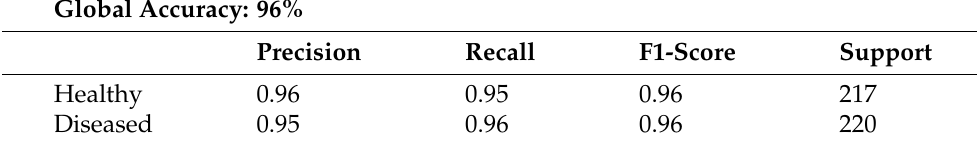
Table 6. Metric results for the test dataset—CNN results. This set is the same previously separated for the MLP.